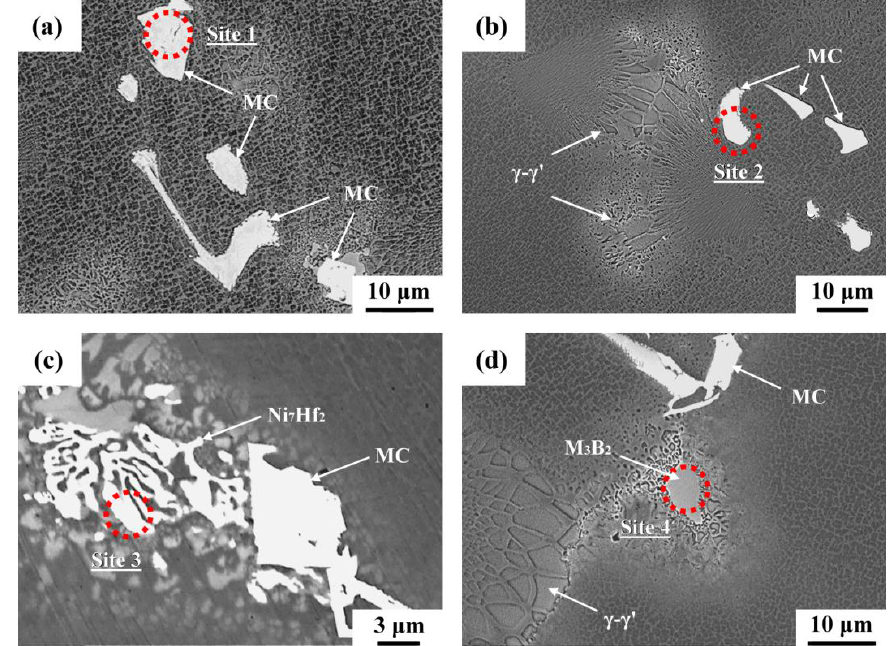
Figure 3. SEM images illustrating the cast microstructures of the Mar-M004 superalloy: ( a ) the metal carbides (MC) carbides in different shapes; ( b ) a γ-γ′ eutectic at the boundaries; ( c ) lamellar eutectics and MC carbide at the boundaries; and ( d ) the presence of borides at the boundaries. EPMA quantitative chemical analyses were used in order to measure compositions of the complex constituents along interdendritic boundaries. Although the precise chemical